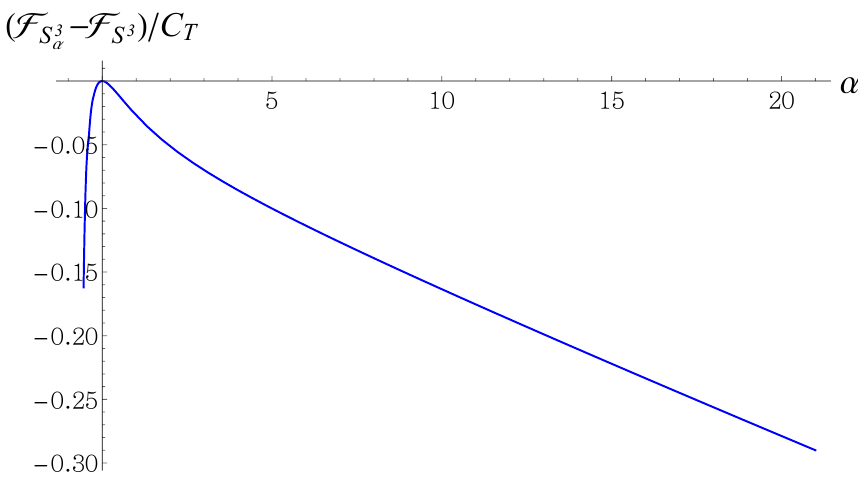
Figure 1 . The free energy for a conformally coupled scalar on the squashed S 3 as a function of the squashing parameter (cid:11)